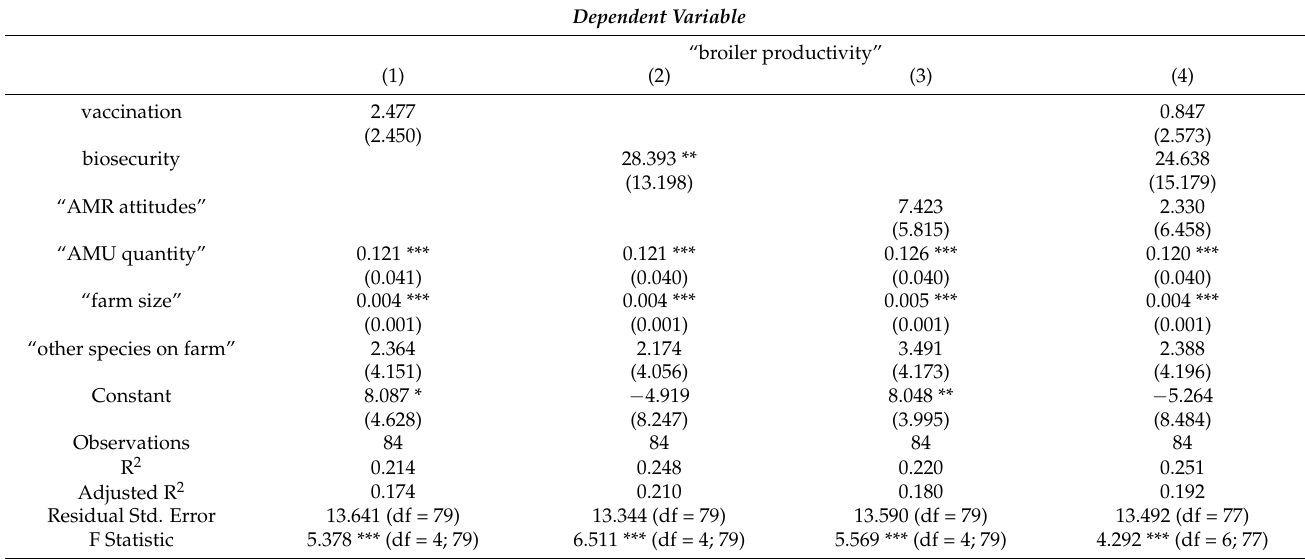
Table 5. Determinants of productivity (broilers).